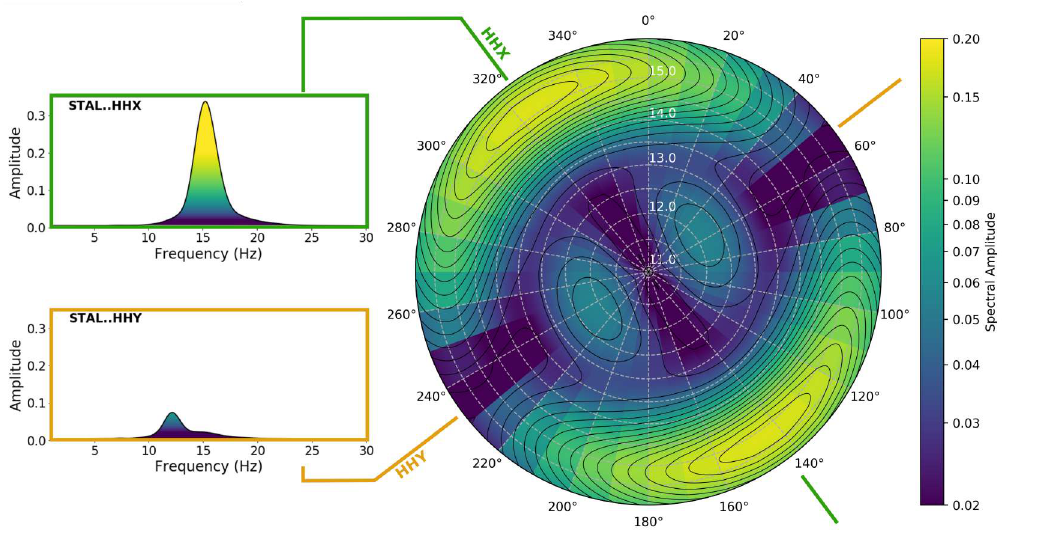
Figure 6. Polar spectral plot of the data measured with the sensor on the Minaret stalagmite (STAL) oriented N52 ◦ E ( Y -axis). The radius axis shows the frequency from 11 to 16 Hz. Black lines highlight the variations in the color-mapped spectral amplitude. On the left, two examples of spectra are